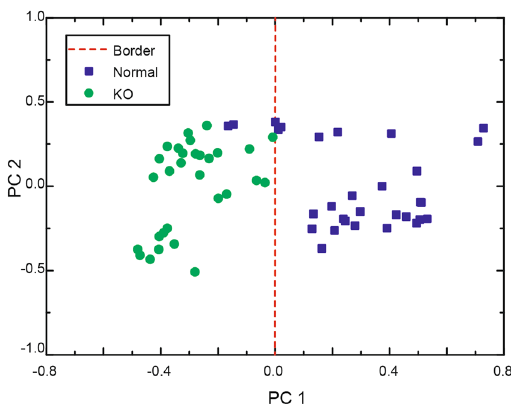
Figure 3. Chemometric analysis of myelin deficit brain and normal brain. Score plot of the first two principle components for the Rheb1 KO (green circular dots) and normal mouse (blue square) brains samples. Red dashed lines show the boundary between the Rheb1 KO and normal brain